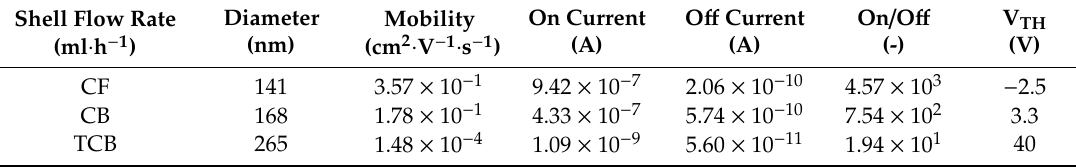
Figure 11. Transfer ( I DS and I DS1 / 2 versus V GS at V DS = − 60 V) and output characteristics of P3HT electrospun nanofibers prepared from ( a , d ) CF; ( b , e ) CB and ( c , f ) TCB systems. Table 1. Diameters and electrical properties of the devices prepared from three di ff erent solvent systems. Shell Flow Rate